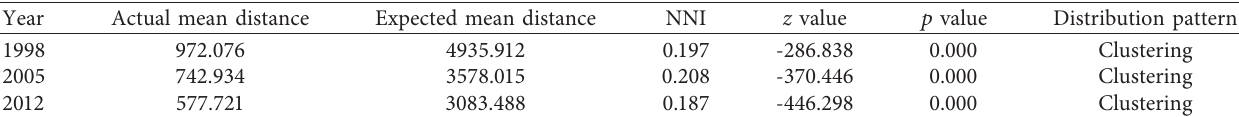
Table 1: Nearest-neighbor index and spatial distribution pattern of water pollution-intensive enterprises locations in the Yangtze River Economic Belt.